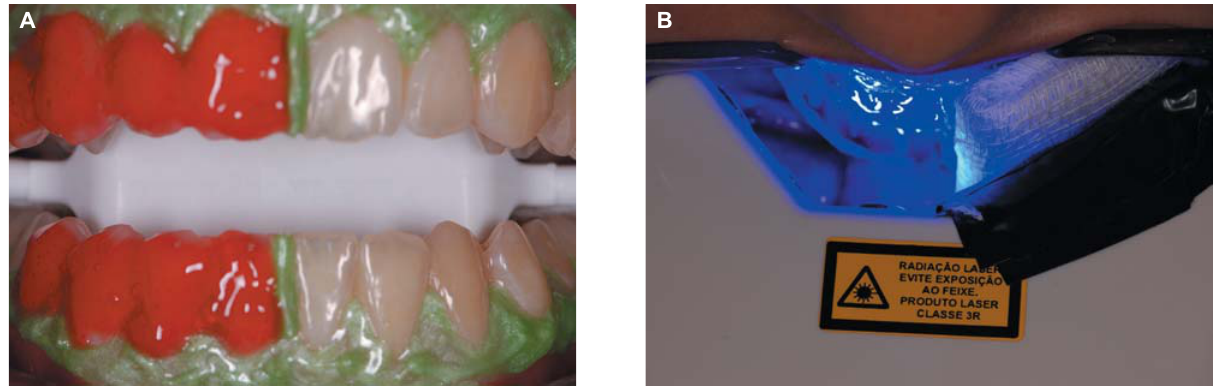
Figure 3- Clinical bleaching procedure in groups 1 and 2: A- bleaching gel application in the right side arcs; B- activation of the gel with hibrid light (HL) in the right side arcs and protection of the left side arcs